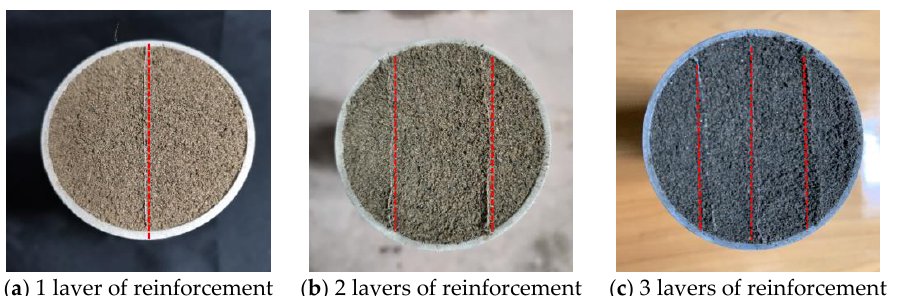
Figure 6. Sample diagram of reinforced tailings.